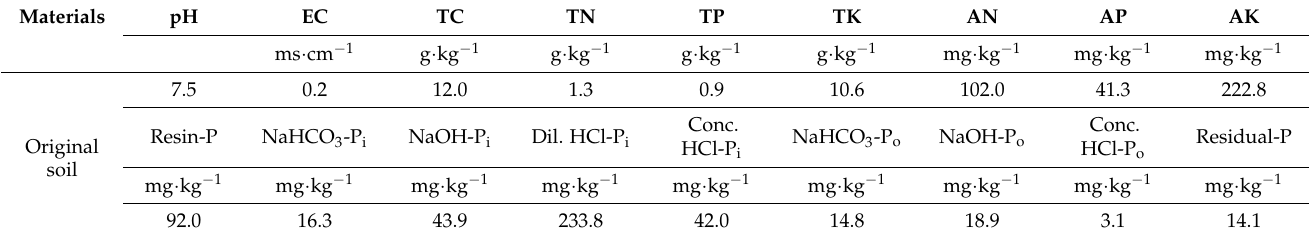
Table 1. Basic properties and P fraction content of the tested materials.